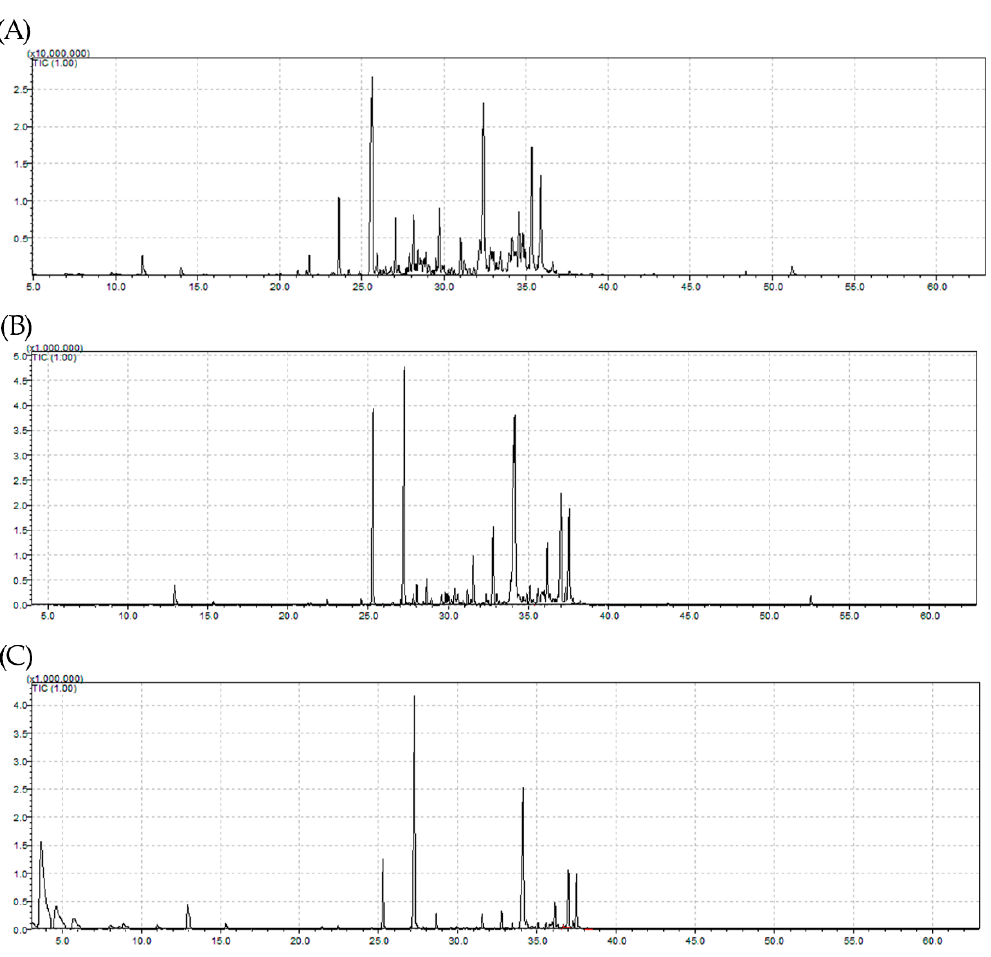
Figure 1. Ion chromatograms of Myrcia eximia DC essential oils (Eos) injected in GC / MS: ( A ) sample collected in 2017 by hydrodistillation (HD), ( B ) sample collected in 2018 by HD, and ( C ) sample collected in 2018 by steam distillation (SD). The x- axis represents the retention time, while the y- axis represents the relative concentration. Table 1. Chemical composition of essential oils extracted from leaves of Myrcia eximia DC, at di ff erent periods, by hydrodistillation (HD) and steam distillation